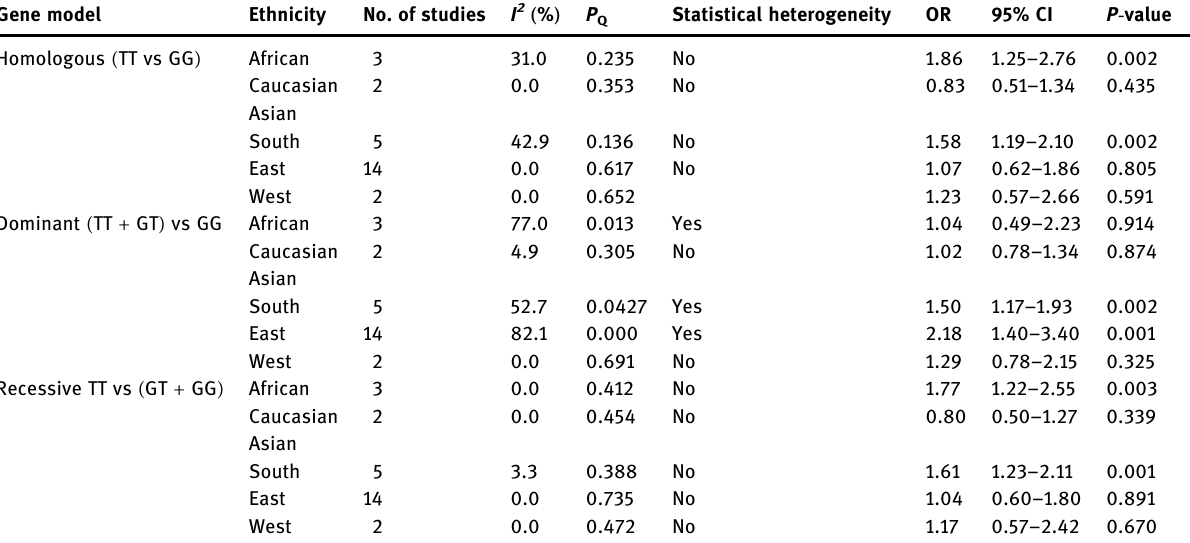
Table 2: ORs of di ff erent ethnicities for eNOS 894 G < T polymorphism and DN susceptibility Gene model